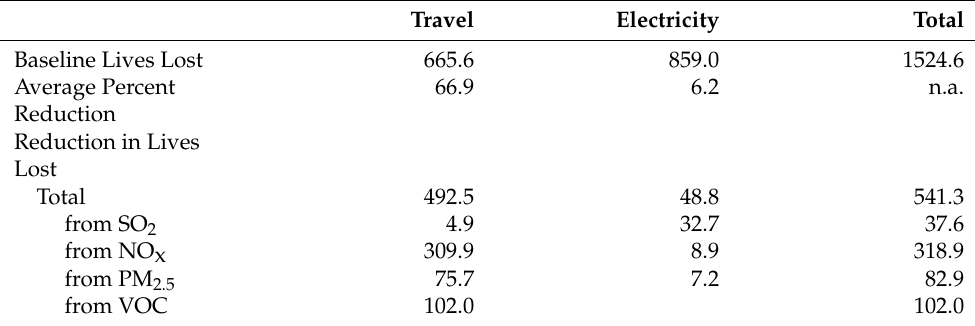
Table A2. Reduction in deaths from reduced air pollution—StreetLight VMT Travel